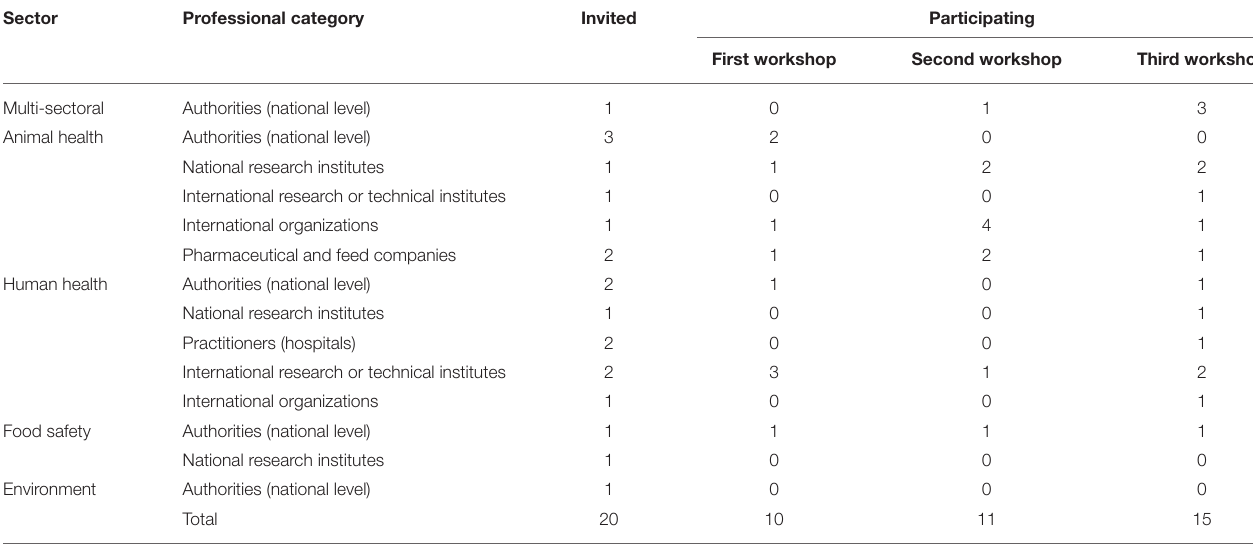
TABLE 2 | Description of the stakeholders invited and participating in the participatory process in Vietnam.